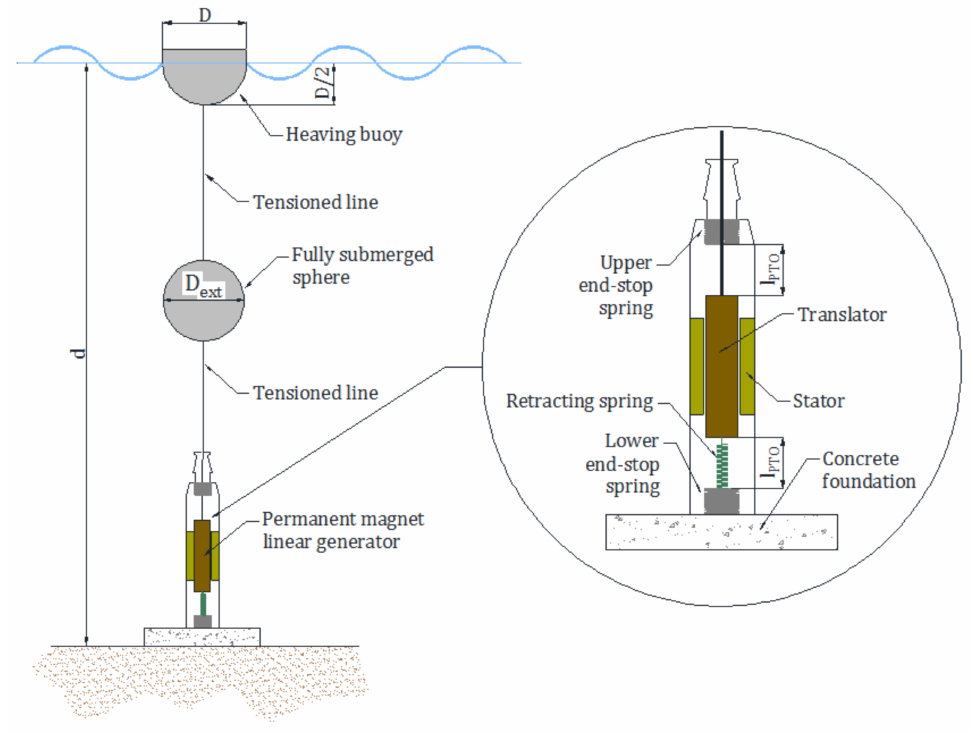
Figure 1. Heaving point absorber with permanent magnet linear